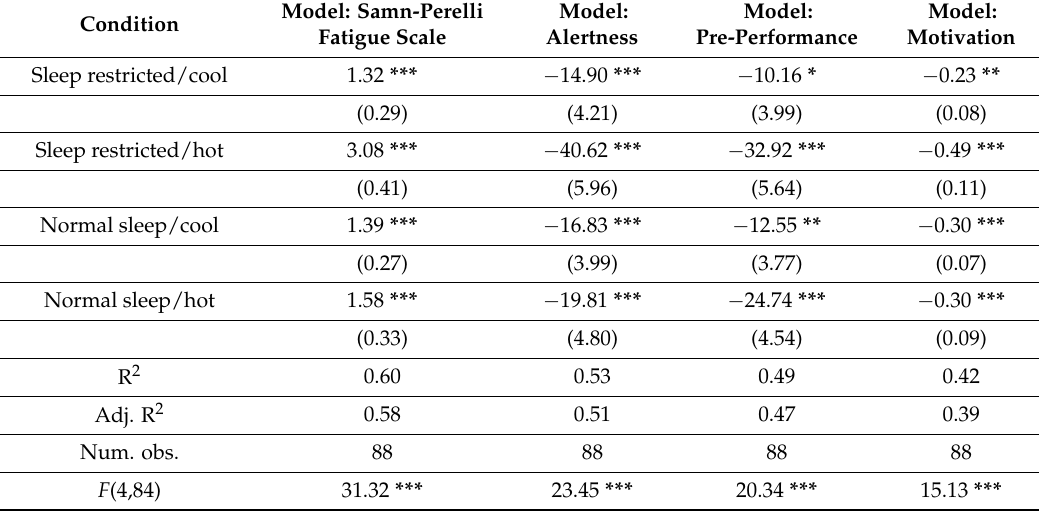
Table 2. ANOVAs predicting changes in standardised outcome scores for subjective measures. Models for each outcome (7) were run separately for changes from baseline to test ( Panel A ) and test to recovery ( Panel B ). Panel A. Changes baseline to